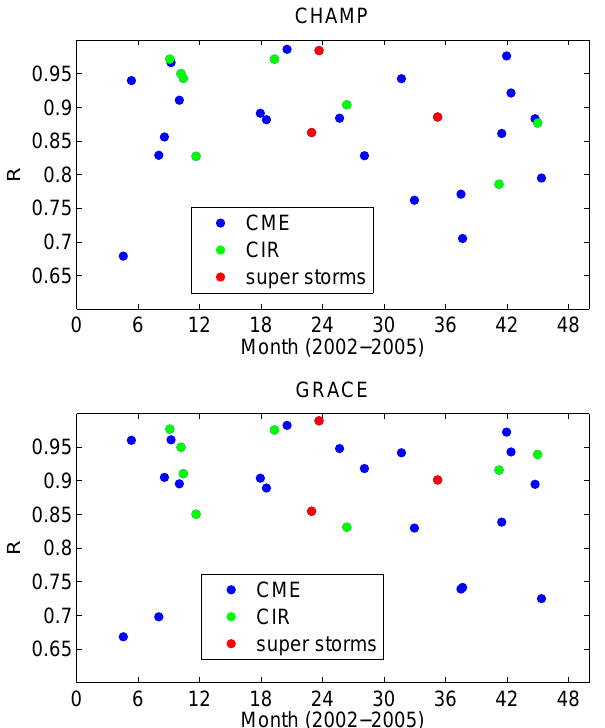
Fig. 7. The correlation coefficient R between the prediction and the measurement for all the storms, in the same format as Fig. 4.